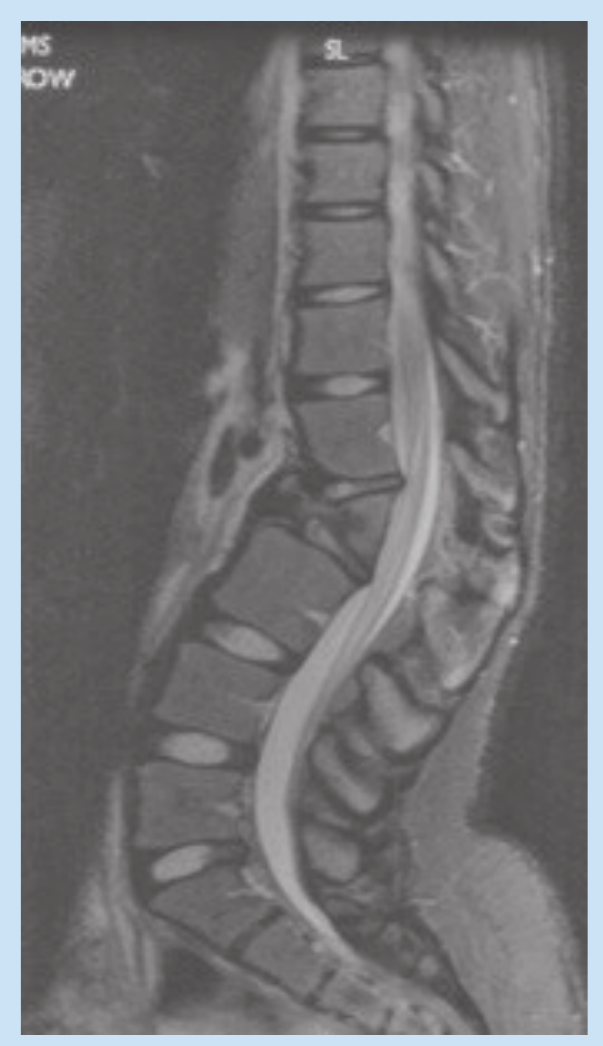
Fig 2. T2 sagittal image. Predominantly anterior vertebral body destruc- tion of L2, with gibbus formation.